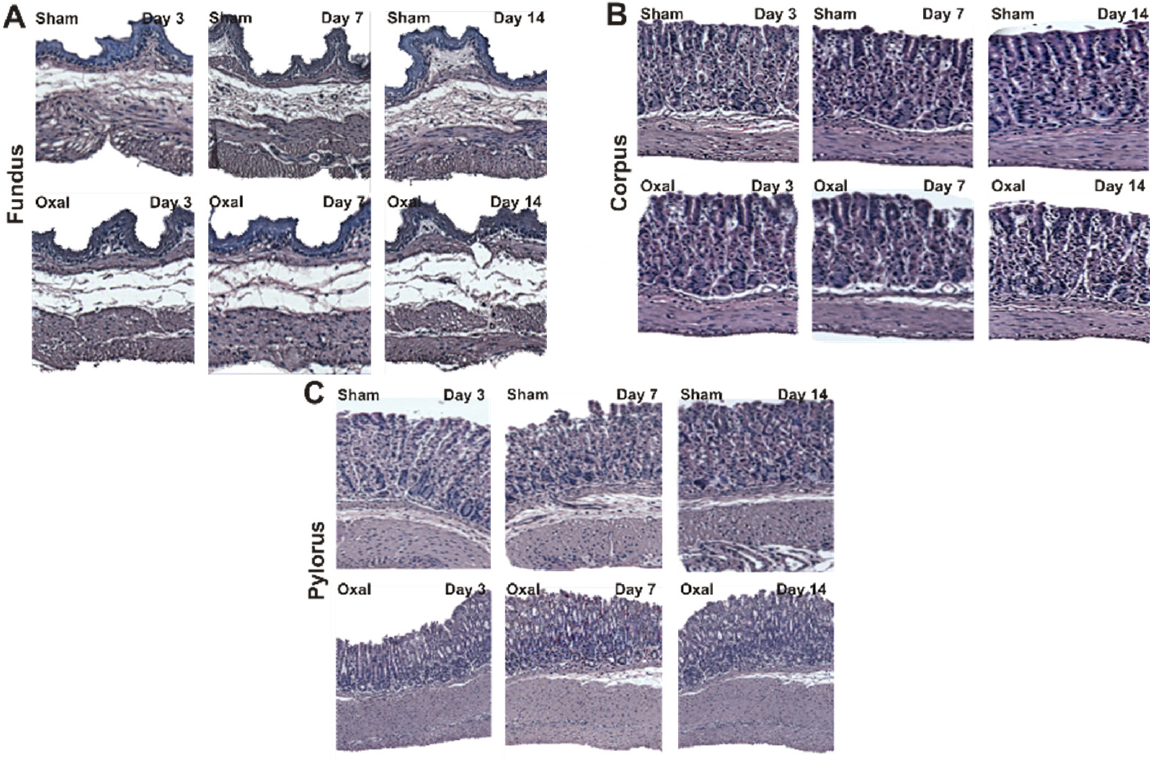
Figure 2. Histological assessment of changes in the morphology of the stomach in chronic oxaliplatin treated mice. ( A – C ) Hematoxylin and eosin staining of the fundus ( A ), corpus ( B ), and pylorus ( C ) at days 3, 7, and 14 following repeated oxaliplatin injection and sham treatment. 3.3. Effects of Oxaliplatin Treatment on the Myenteric Neurons and Subpopulation of nNOS-IR Neurons in the Stomach The total number of neurons in wholemount LMMP preparations of the gastric corpus was counted using the pan-neuronal marker PGP9.5. Repeated oxaliplatin administration caused a substantial decrease in the number of neurons per area (0.25 mm 2 ) within the myenteric plexus of the stomach at day 7 (81 ± 4) and 14 (62 ± 6) (n = 4 mice/group) compared to the sham group (day 7: 108 ± 3; day 14: 103 ± 5; p < 0.001; n = 4 mice/group, Figure 3A,B).